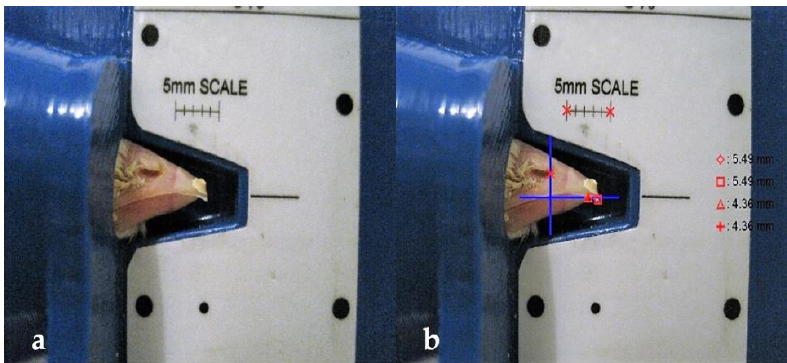
Figure 1. ( a ) Nova-Tech Engineering LLC beak scale; ( b )calculation of beak length using ImageJ software.